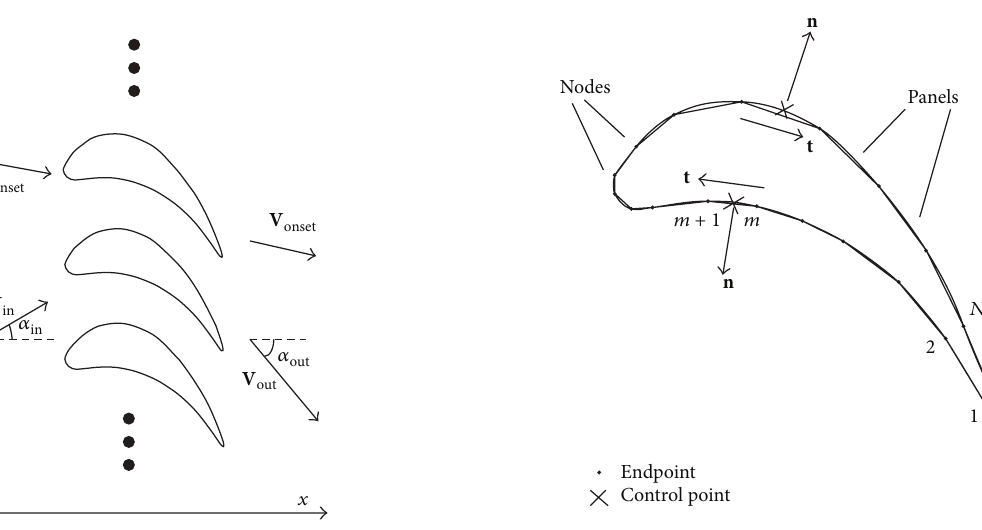
Figure 2: Panel representation of